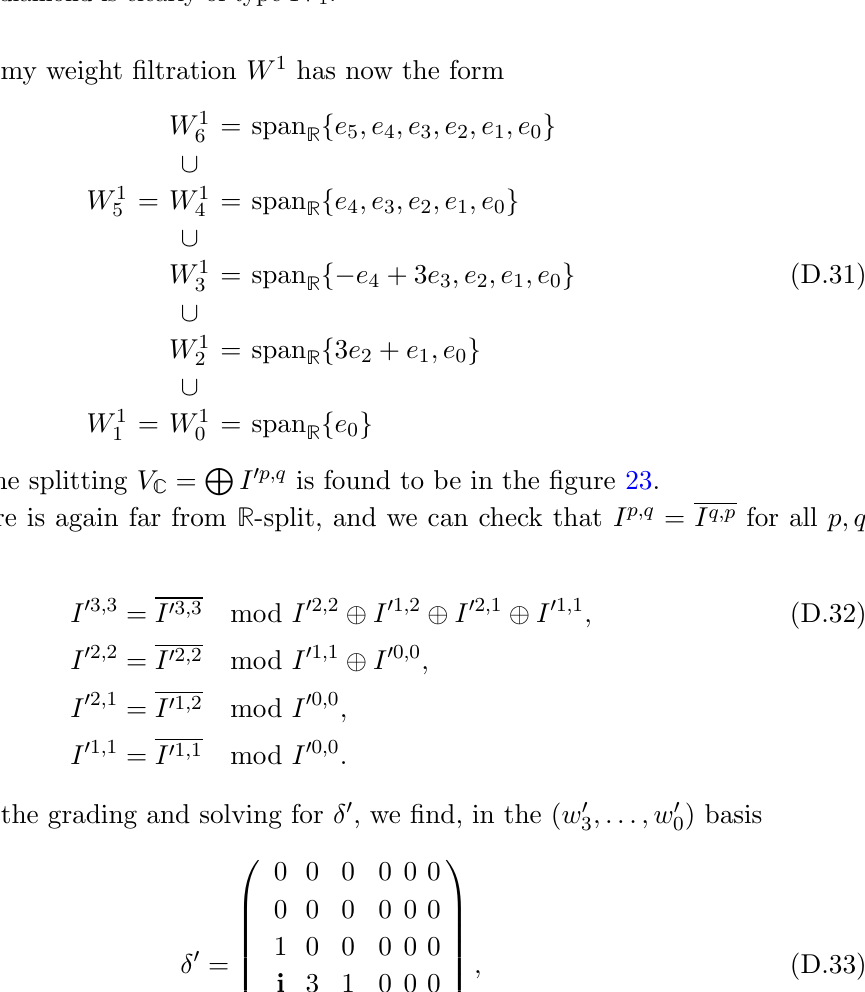
Figure 23 . The Hodge diamond of the mixed Hodge structure ( V; F 0 ; W 1 ), in which each dot near the ( p; q )-site represents a base vector of the corresponding subspace I 0 p;q . The arrows show the action of N 1 . The diamond is clearly of type IV 1